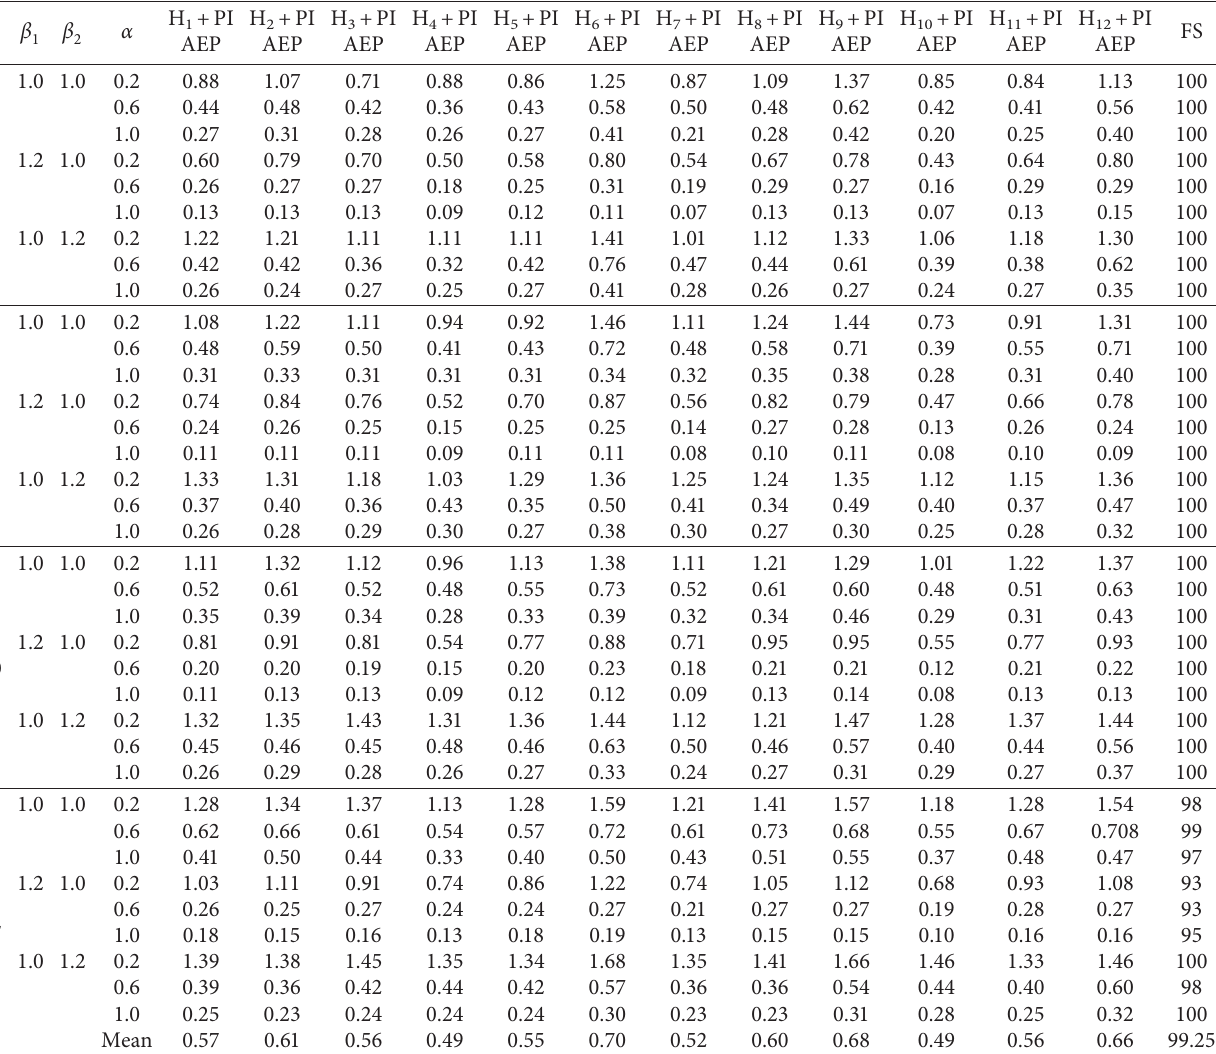
Table 2: The AEPs of 12 heuristics, Hi +PIs.